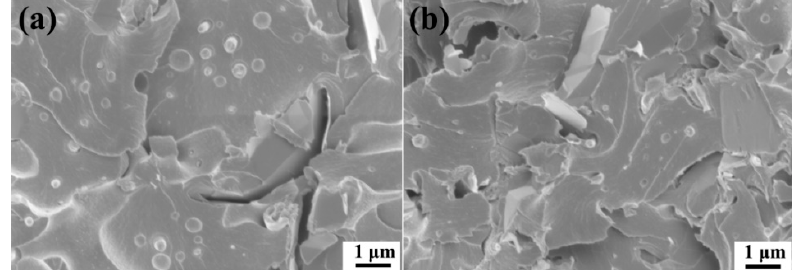
Figure 12. SEM images of CT fracture surfaces of GnP-5/PES/epoxy composite: ( a ) 1 wt % GnP-5 and ( b ) 3 wt % GnP-5.